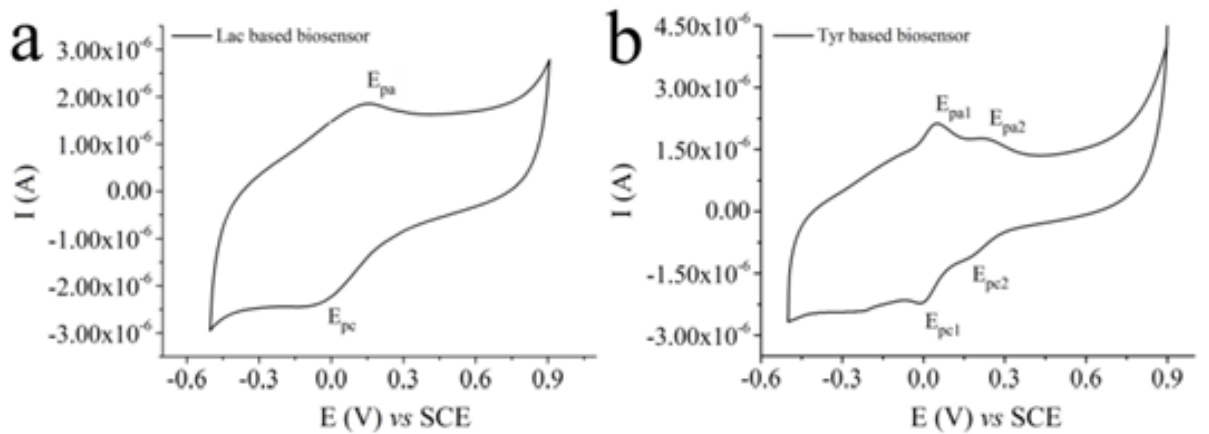
Figure 14. CV characterizations recorded in 0.1 M acetate buffer, pH 4.5 for a biosensor obtained by casting 10 µ L of a suspension containing 8 mg · mL − 1 Lac ( a ), and in 0.05 M PBS, pH 6.5, for a biosensor obtained by casting 10 µ L of a suspension containing 6 mg · mL − 1 Tyr, working under Ar atmosphere ( b ). Scan rate: 0.005 V · s − 1 . Published from [78] with the permission of the publisher.